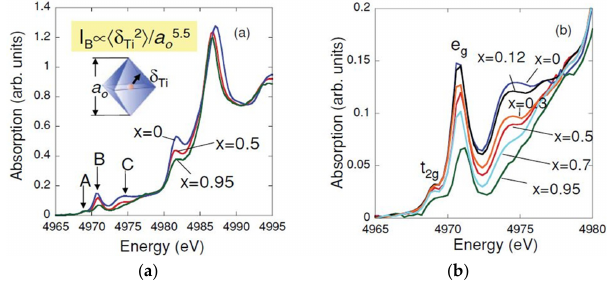
Figure 15. Ti K ‐ absorption edge XANES spectra from Ba(Ti,Zr)O 3 samples studied in [107]. ( a ) Spectra for selected compositions, indicating the pre ‐ edge features A, B and C. Expression (2) from [99] and structural parameters are also shown; ( b ) Ti pre ‐ edge features for all measured compositions, where systematic variation in areas of features B and C is especially noteworthy. Reprinted from [107]. Copyright by the American Physical Society, 2011.